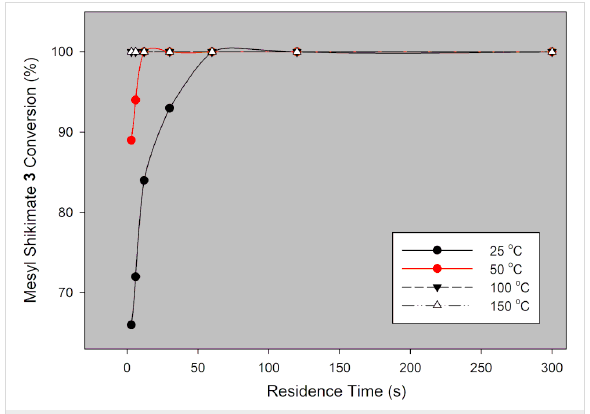
Figure 8: Mesyl shikimate azidation conversion in a continuous-flow system using DPPA.